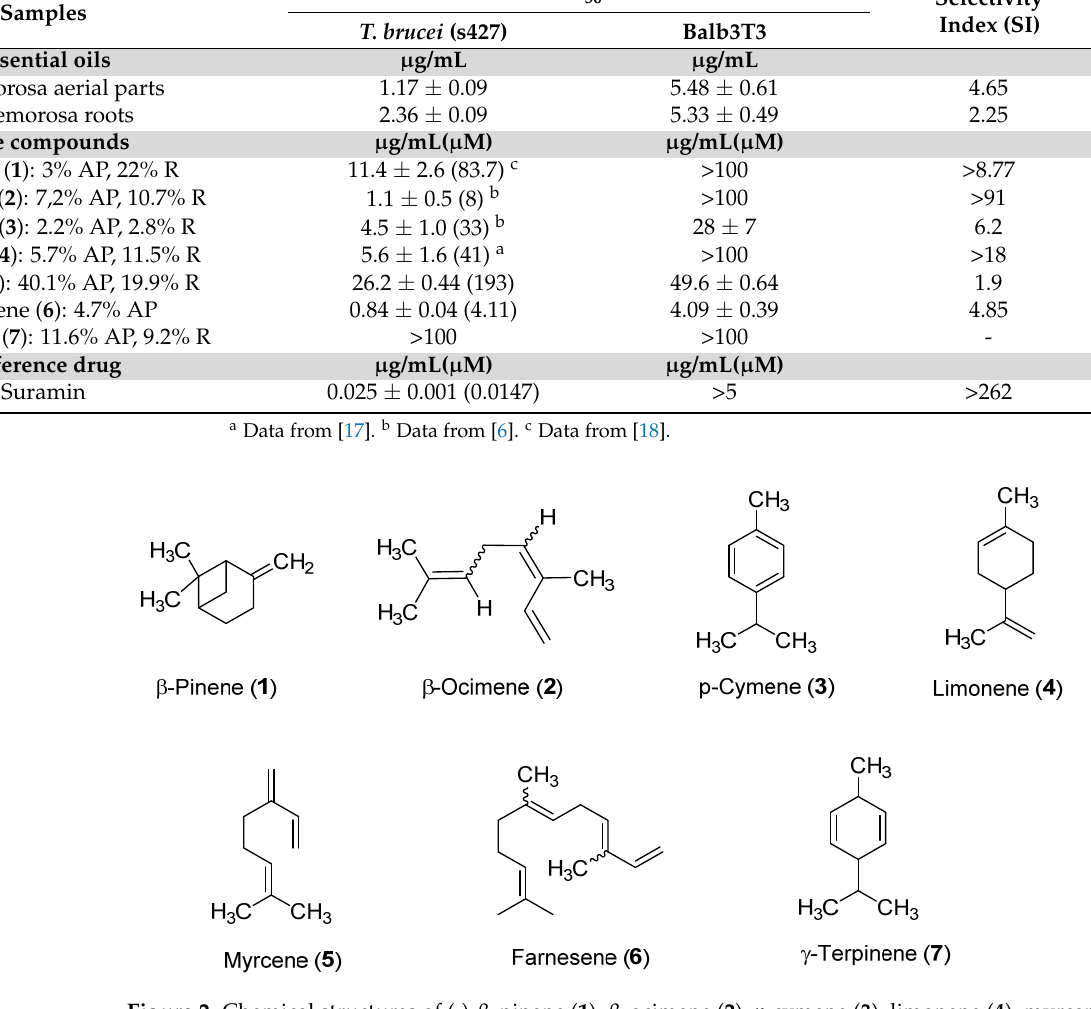
Figure 2. Chemical structures of (-)- β -pinene ( 1 ), β -ocimene ( 2 ), p -cymene ( 3 ), limonene ( 4 ), myrcene ( 5 ), farnesene ( 6 ), and γ -terpinene ( 7 ).